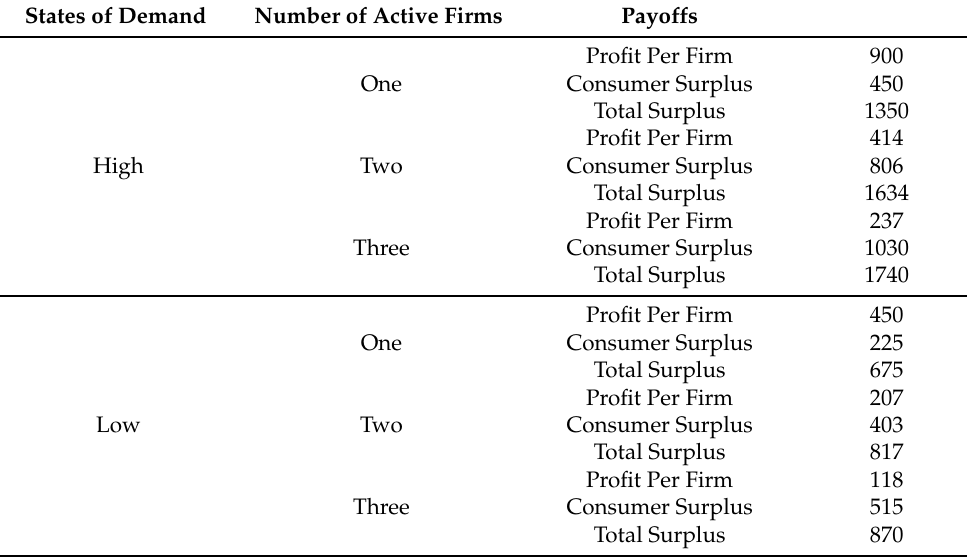
Table 6. Stage payoffs under different states in the Cournot